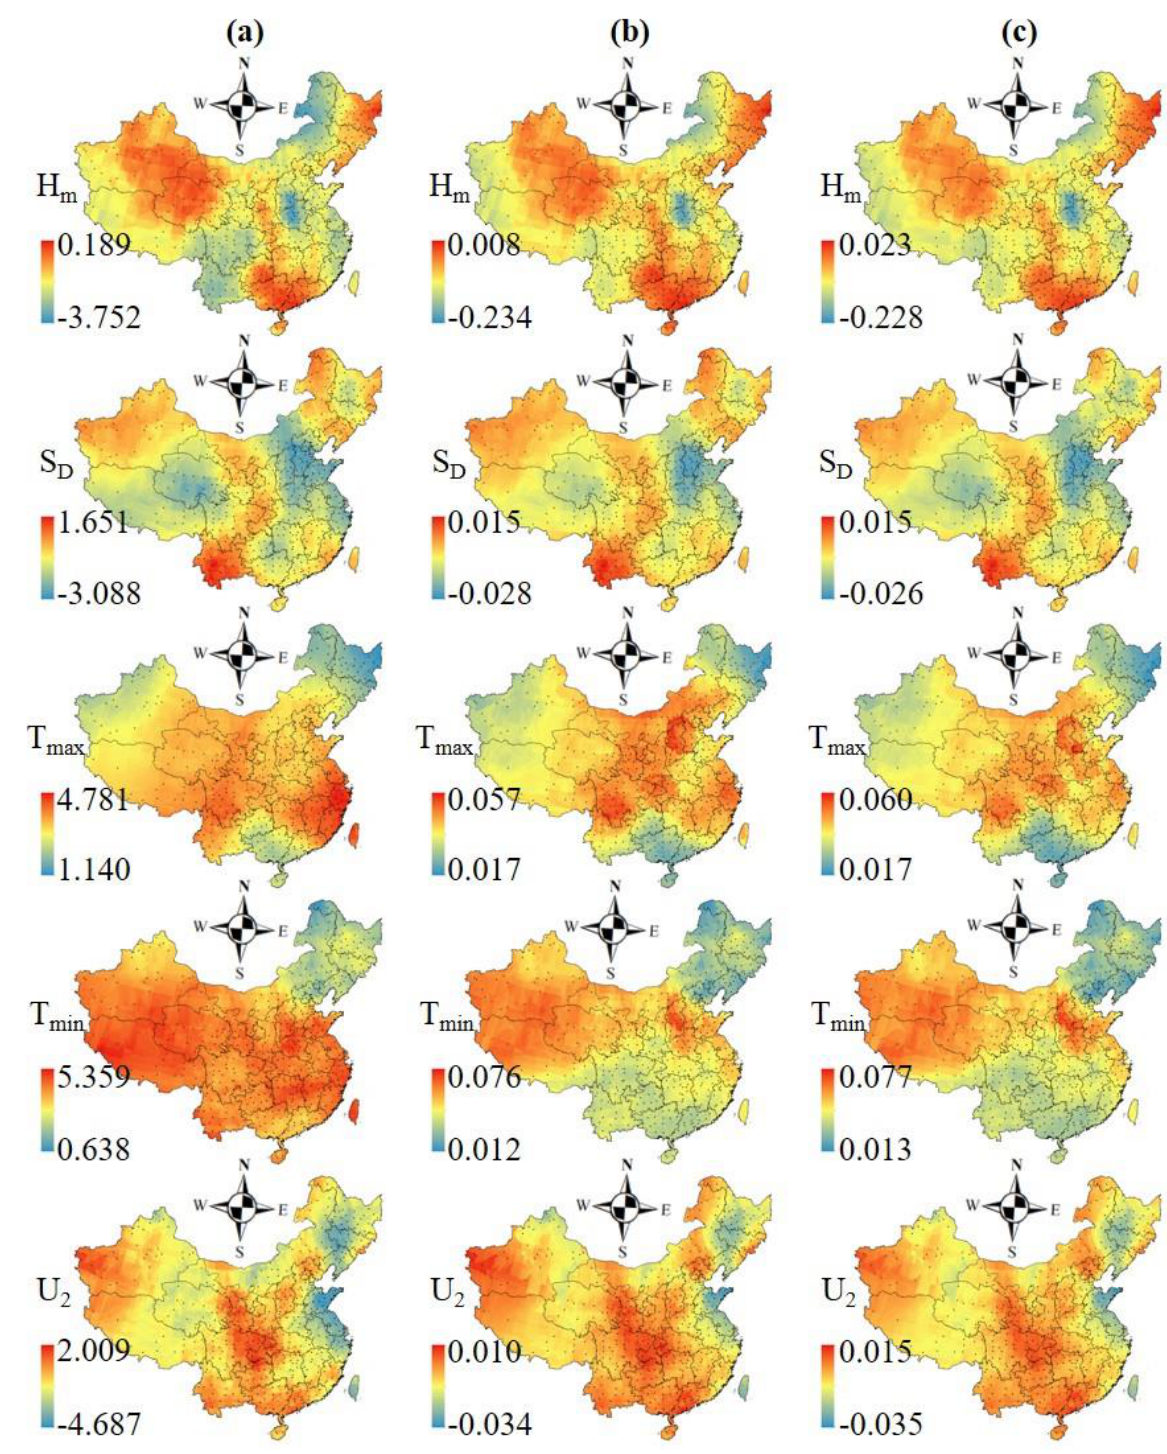
Figure 5. Spatial distribution maps for the trend analysis of the climatic variables: ( a ) M – K Z S , ( b ) ( b ) Sen’s slope, and ( c ) linear Sen’s slope, and ( c ) linear trend.